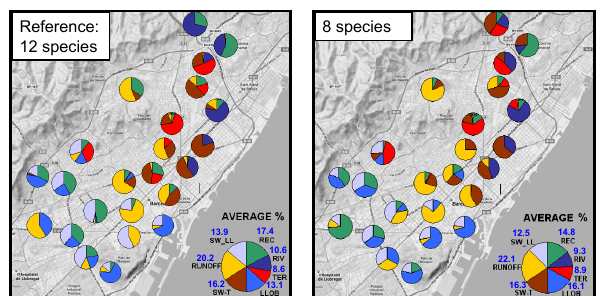
Fig. 5. Comparison of mixing results obtained using 24 wells and 8 recharge sources and either 12 (left) or 8 (right) species. Results are similar for large portions of the aquifer. However, the mixing ra- tios for northern wells are significantly different. Results of the left plot are more consistent with our conceptual model, despite the fact that the four additional species display non-conservative